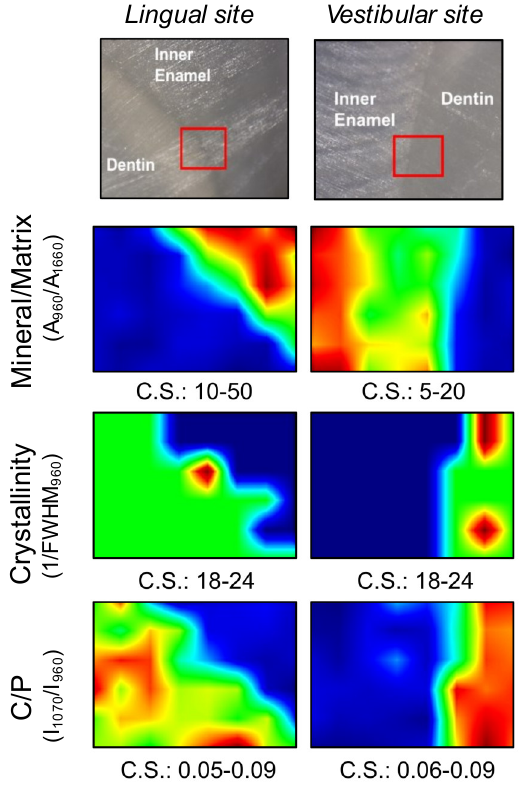
Figure 3. Raman mapping analysis of representative areas at the inner enamel/dentin interfaces in vestibular and lingual sites of permanent teeth. Photomicrographs reporting the selected areas (red rectangles, 241.5 mm × 167 mm) and corresponding false-color images (241.5 mm × 167 mm) showing the topographical distribution of mineral/matrix (A960/A1660), crystallinity (inversely proportional to FWHM960), and C/P (carbonates/phosphates, I1070/I960) spectral features. Different color scales (C.S.) were used for a better interpretation of the data: exact values are reported below each map (black/blue color corresponds to the lowest values, green intermediate, and red/dark red to the highest values) [48].